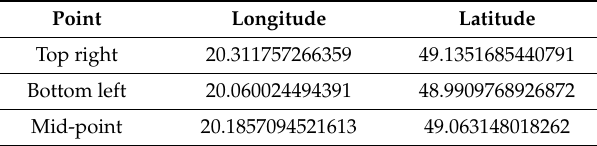
Table 3. Bounding box for the Svit area.